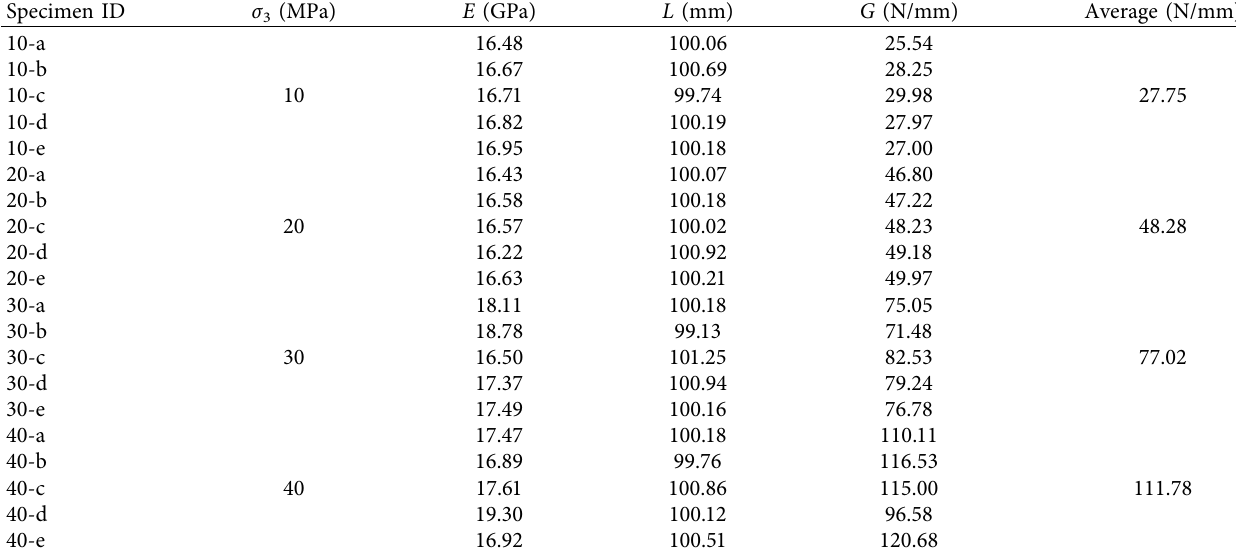
Table 2: Shear fracture energy of rock samples under different confining pressures.